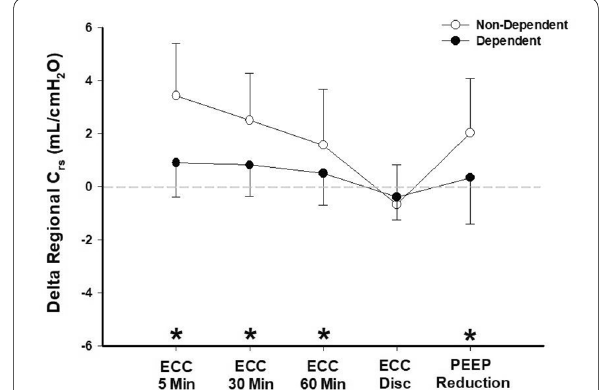
Fig. 4 Variations in regional respiratory system compliance ( C rs ). N 11. Variation in regional respiratory system compliance = (expressed as timepoint regional compliance—baseline regional compliance, C rs ). White dots represent non-dependent lung regions (ventral), black dots represent dependent lung regions (dorsal). ECC external chest-wall compression. * P < 0.05 of absolute values of different non-dependent regional C rs timepoints vs. non-dependent regional C rs baseline